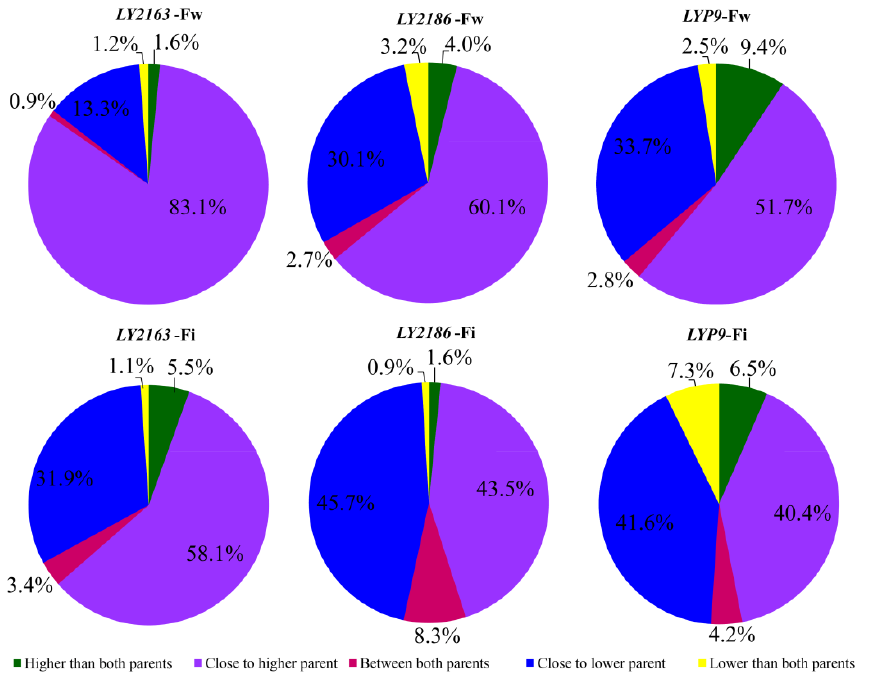
Figure 3. Pie graph representing expression patterns of